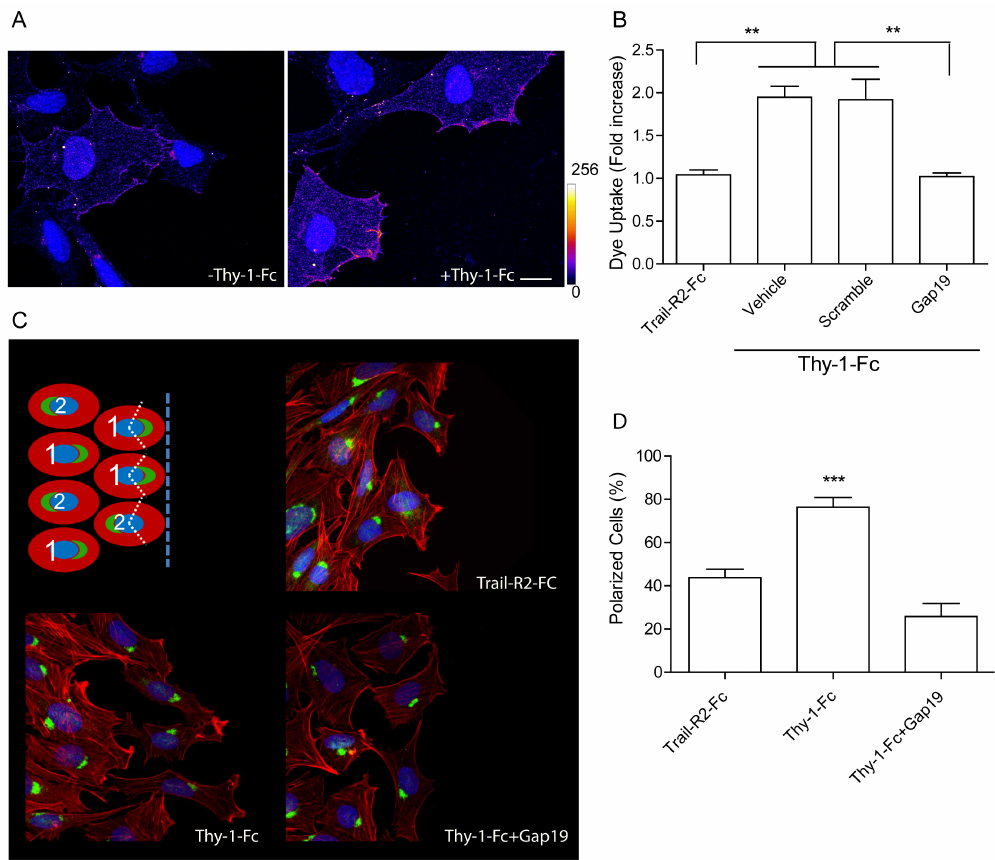
Figure 1. Thy-1 enhances cell surface connexin 43 (Cx43) levels, opens hemichannels, and induces cell polarization. ( A ) Representative images of Cx43 localization in DITNC1 astrocytes before and after Thy-1 addition for 10 min. The heat map of fluorescence intensity indicates relative levels of Cx43, going from 0 (blue) to 256 (white). Scale bar = 10 µ m; ( B ) Lucifer Yellow uptake quantification in astrocytes treated with tumor necrosis factor (TNF) for 48h prior to stimulation with Thy-1-Fc or Trail-R2-Fc (used as a negative control) [4,5]). Cells were pre-incubated with vehicle, a scrambled peptide, or Gap19; ( C ) Representative images of cell polarization. Confluent cultures of astrocytes were scratched with a pipette tip and Golgi localization was determined using an anti-giantin antibody. Phalloidin-rhodamine was used to identify the cell border. Polarization was defined as positioning of the Golgi apparatus within an angle of 120 ◦ facing the wounded area (see scheme in the top left panel). Scale bar = 10 µ m; ( D ) Quantification of Figure 1C. Results from at least three independent experiments showing mean ± s.e.m. ** p < 0.01, *** p <